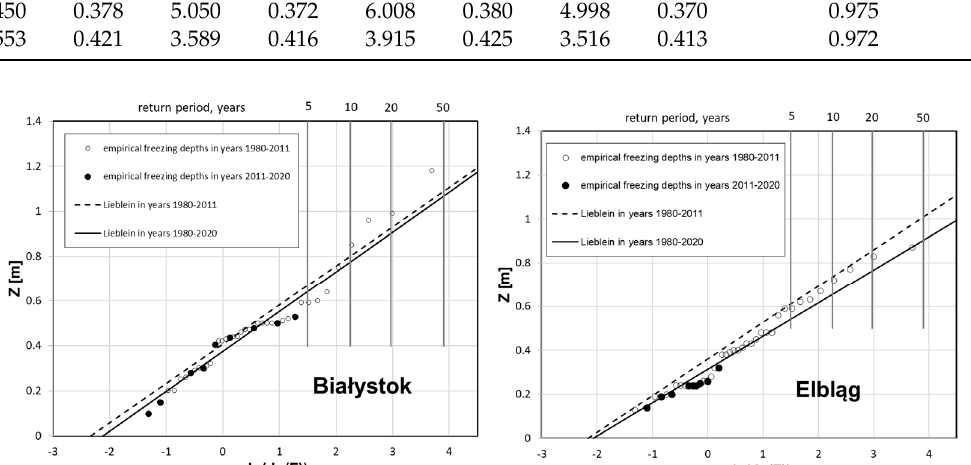
Figure 7. Comparison of predicted and measurement value for chosen location: Białystok ( left ) and Elbl ą g ( right ) station.